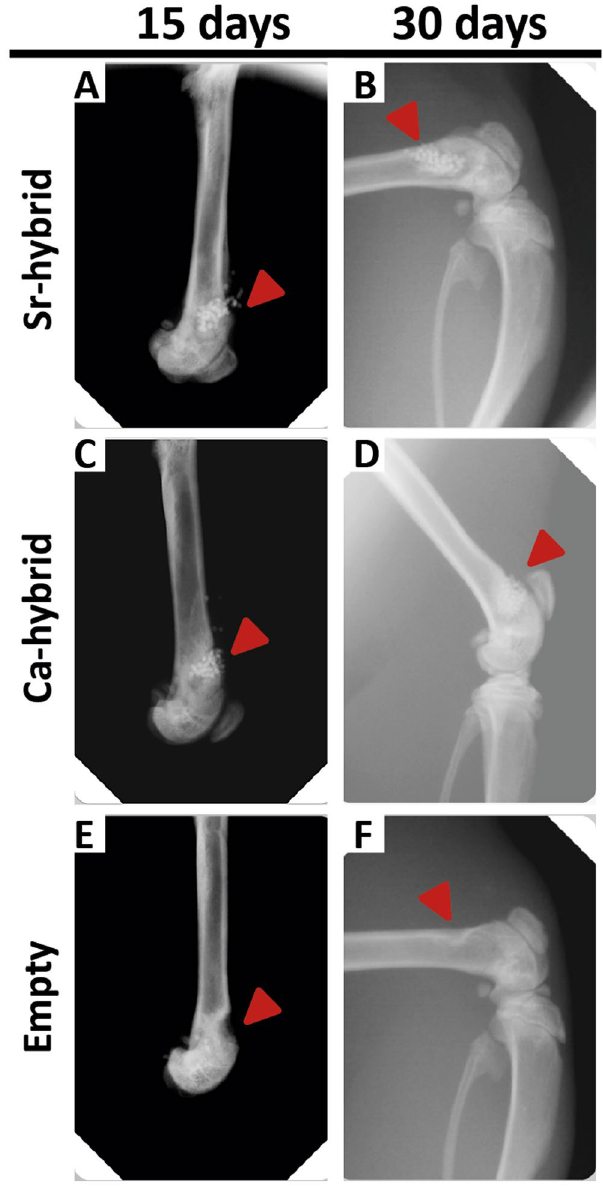
Figure 2. Radiographic imaging follow-up. Representative lateral X-Ray images from right rat femurs of Sr- hybrid ( A and B ), Ca-hybrid-filled ( C and D ) and empty ( E and F ) defects at 15 days ( A , C and E ) and 30 days ( B , D and F ) post-surgery. Arrows pinpoint site of created defect, filled or empty. Microspheres can be observed as circular objects more radiopaque than